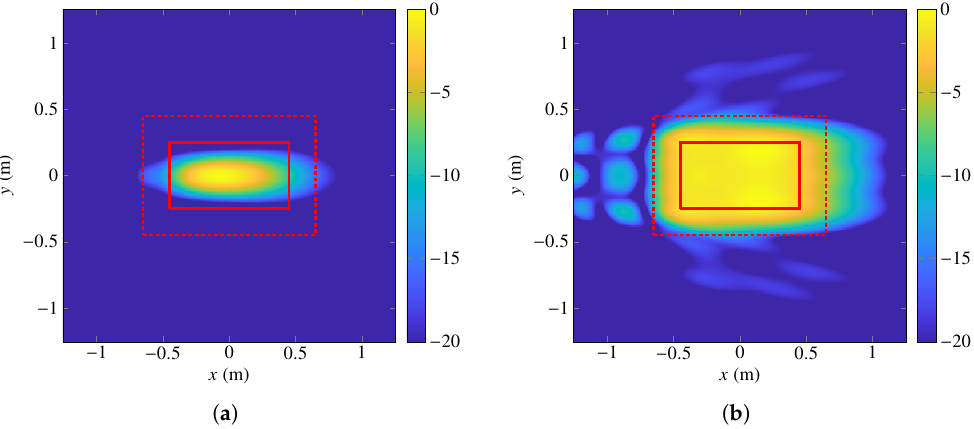
Figure 8. Normalized magnitude of the electric field ( a ) for the starting point of the POS and ( b ) the result of the POS simulated with a MoM-LP at 28GHz. Coverage zone is represented by a solid red line and transition zone by a dashed red line. Near field is plotted in the